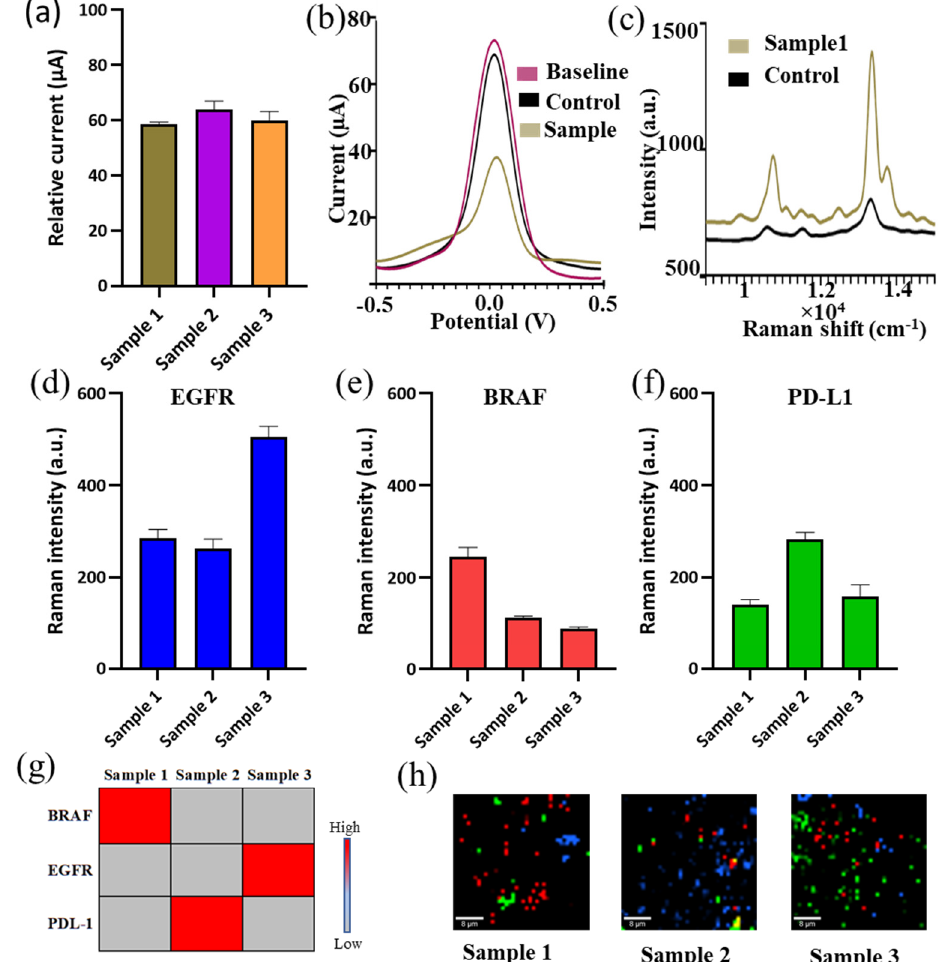
Figure 4. Ensemble and individual detection of mixtures of BRAF, EGFR, and PDL-1. ( a ) represents the DPV signals of ensemble measurements of samples 1 to 3; ( b , c ) represents the DPV measurement and corresponding SERS spectra of sample 1. ( d – f ) Average SERS intensities of three biomarkers analysed. The error bars represent the standard errors from three replicate runs. ( g ) Heatmap of SERS intensities for three proteins in each sample ( h ) False colour SERS images (Red = BRAF, green = EGFR and blue = PDL-1) of sample 1, sample 2 and sample 3, respectively.